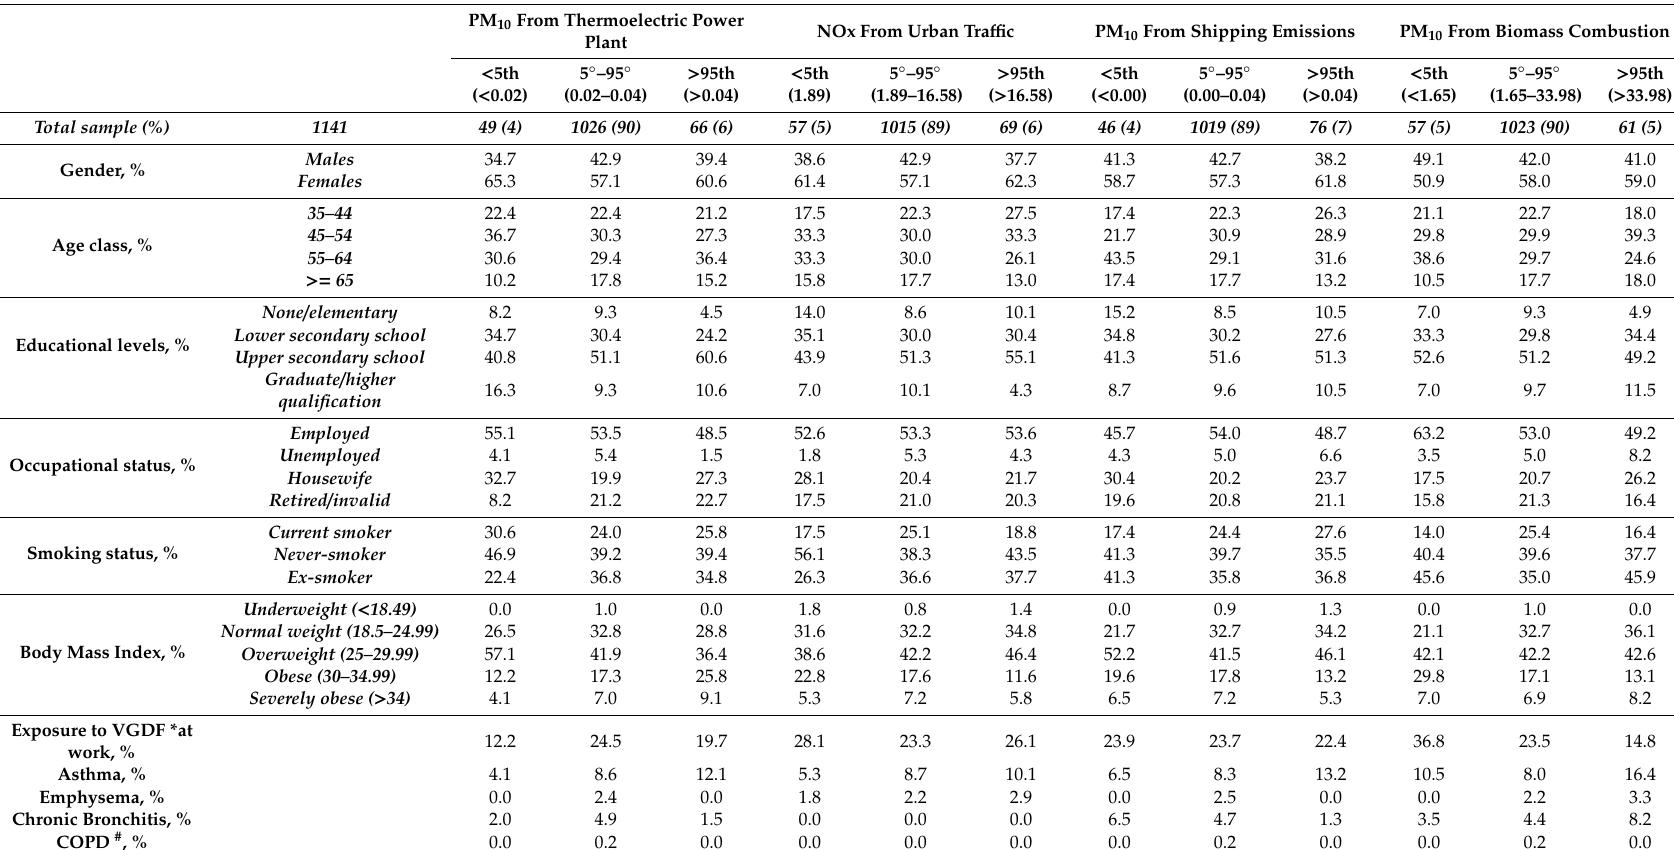
Table 1. Descriptive individual characteristics of the sample according to exposure categories (low exposure, < 5th; medium exposure, 5th–95th and high exposure, > 95th percentile cut-o ff